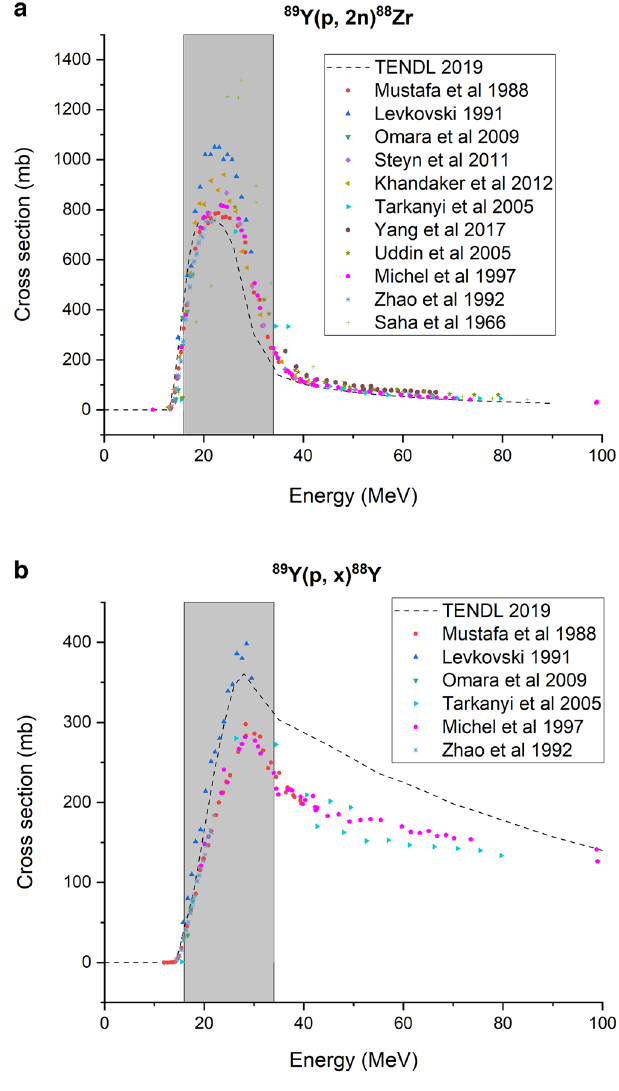
Figure 1. ( a ) Experimental literature data 23,28–37 (points) and model predicted TENDL 2019 data 38 (dotted line) for the 89 Y(p,2n) 88 Zr cross section and the predicted Y target energy window (gray). ( b ) Experimental literature data 23,29–32,37 (points) and model predicted TENDL 2019 data 38 (dotted line) for the 89 Y(p,x) 88 Y cross section and the predicted Y target energy window